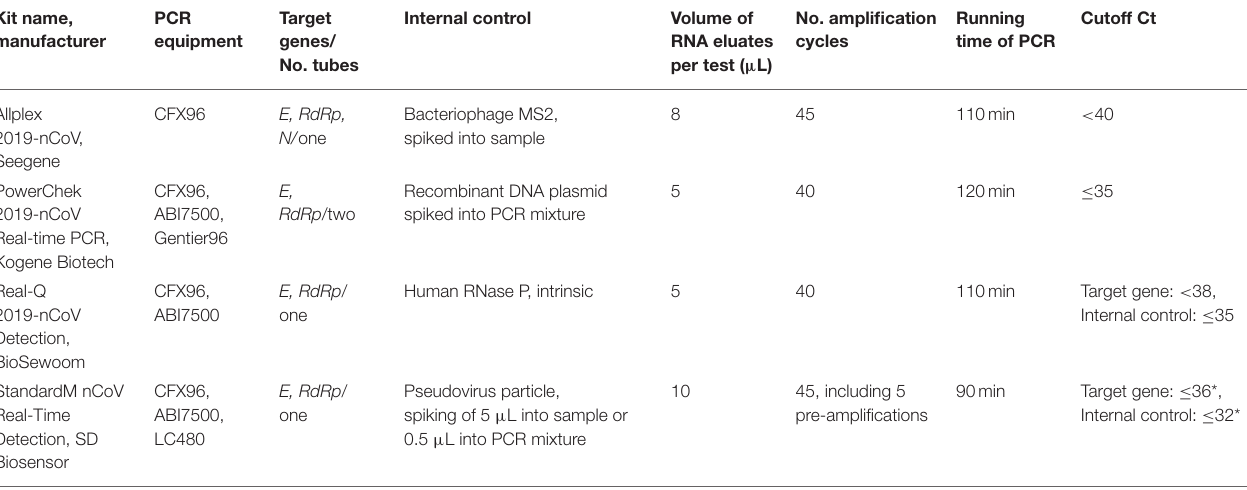
TABLE 1 | Specifications and PCR conditions of the four commercial kits used for SARS-CoV-2 RNA